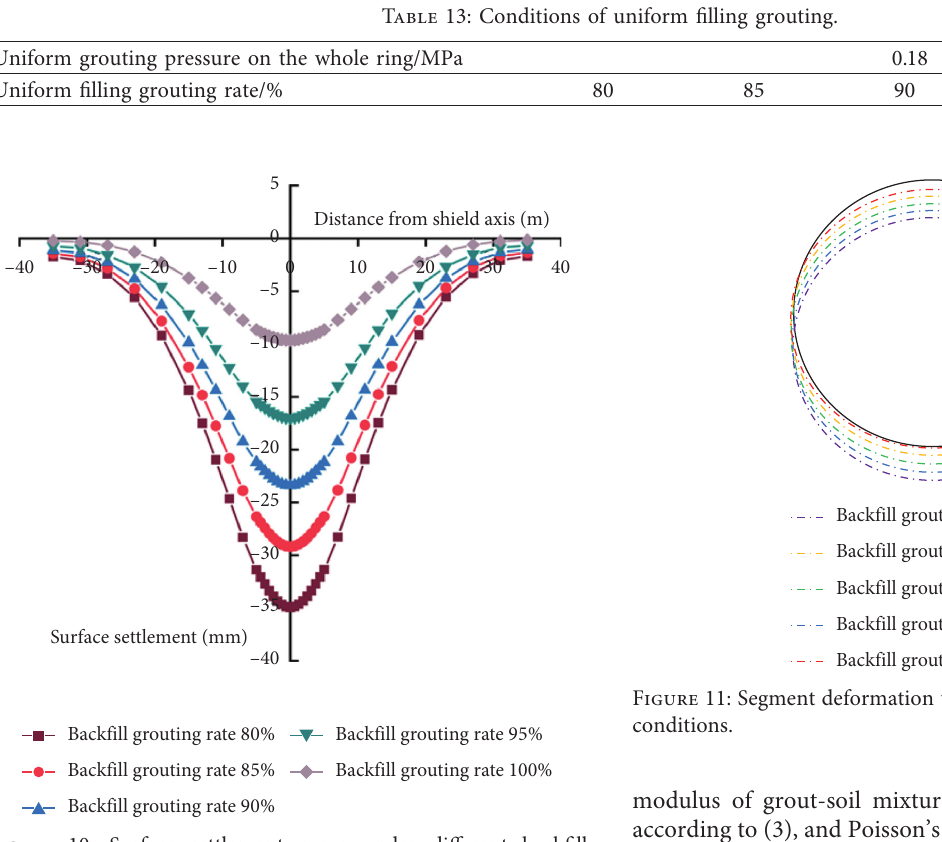
Figure 10: Surface settlement curve under different backfill grouting conditions.